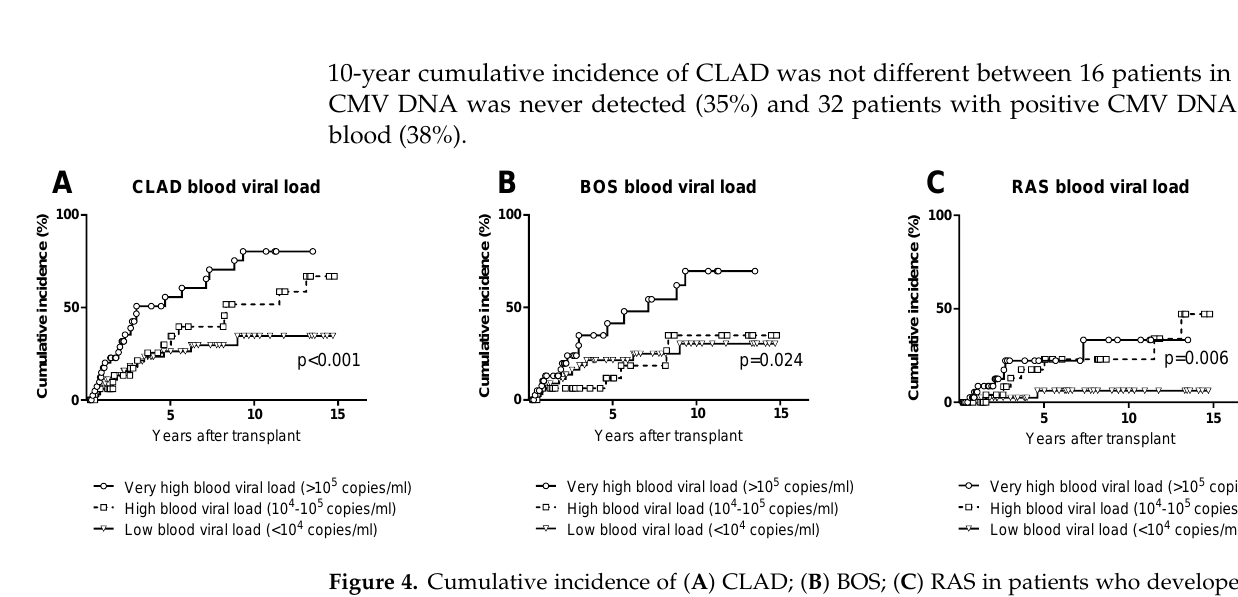
Figure 4. Cumulative incidence of ( A ) CLAD; ( B ) BOS; ( C ) RAS in patients who developed three progressively higher levels of CMV load in the blood.